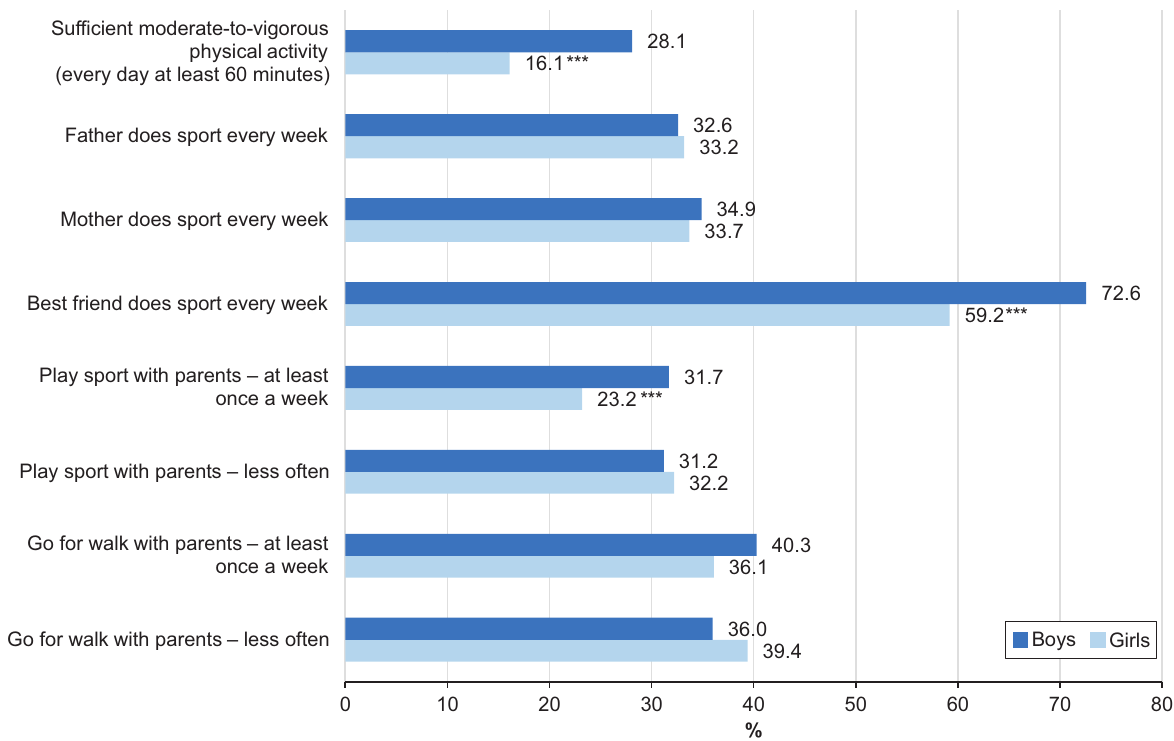
Figure 1. Gender differences in selected variables, prevalence in % (3,012 Slovak adolescents aged 12.5–6.0 years, 50.2% boys, approached in 2014 within HBSC study, *** p <